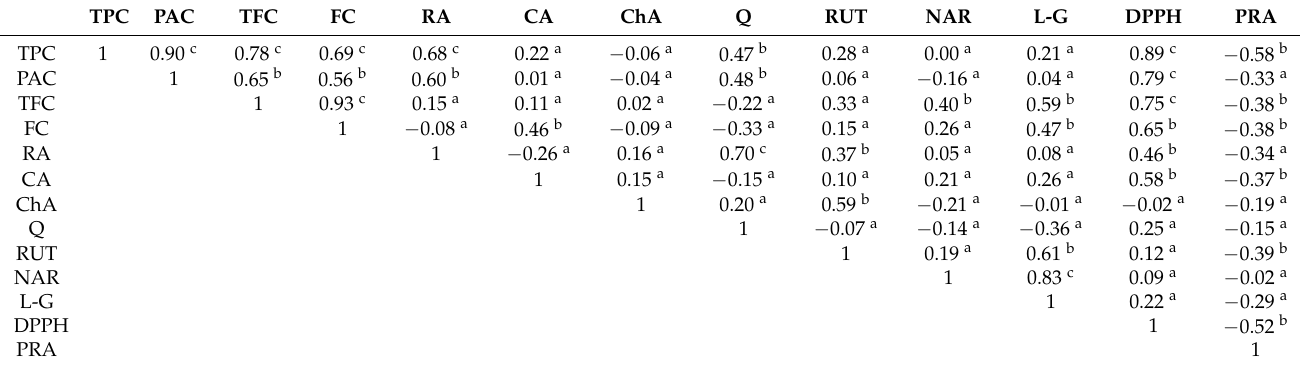
Table 3. Correlation coefficients between the assays used to analyze the phytochemical content (TPC, PAC, TFC, and FC), quantification of chemical compounds (RA—rosmarinic acid, CA—caffeic acid, ChA—chlorogenic acid, Q—quercetin, RUT—rutin, NAR—naringin, L-G—luteolin-7- O -glucoside), antioxidant activity in vitro (DPPH assay), and genoprotective activity in an acellular model (PRA—Plasmid Relaxation